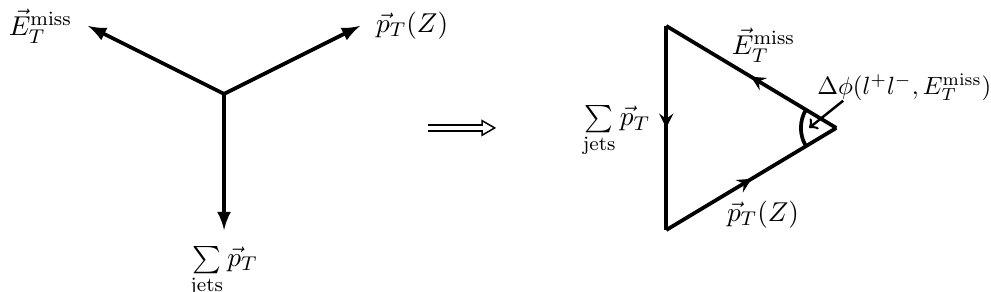
Figure 3 . Sketch of di(cid:11)erent components of dilepton plus E miss events in the transverse plane; the T dilepton system recoils against the missing energy and the vector sum of hadronic p T . Conservation of transverse momentum implies the vectors form a closed triangle, which can be de(cid:12)ned by the lengths of two sides and the enclosed angle, or by the lengths of all three sides.